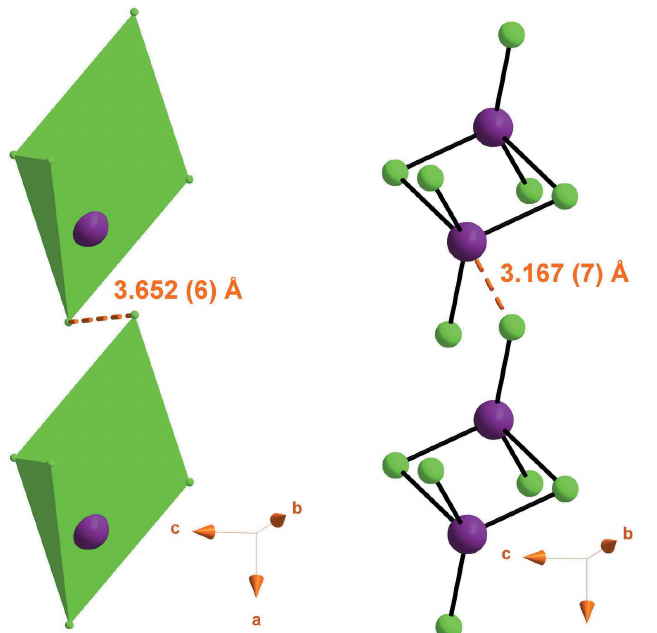
Figure 6 Cl (cid:3)(cid:3)(cid:3) Cl and Hg (cid:3)(cid:3)(cid:3) Cl interactions between hexachloridodimercurate(II) anions dispersed parallel to the a axis in the inorganic column.